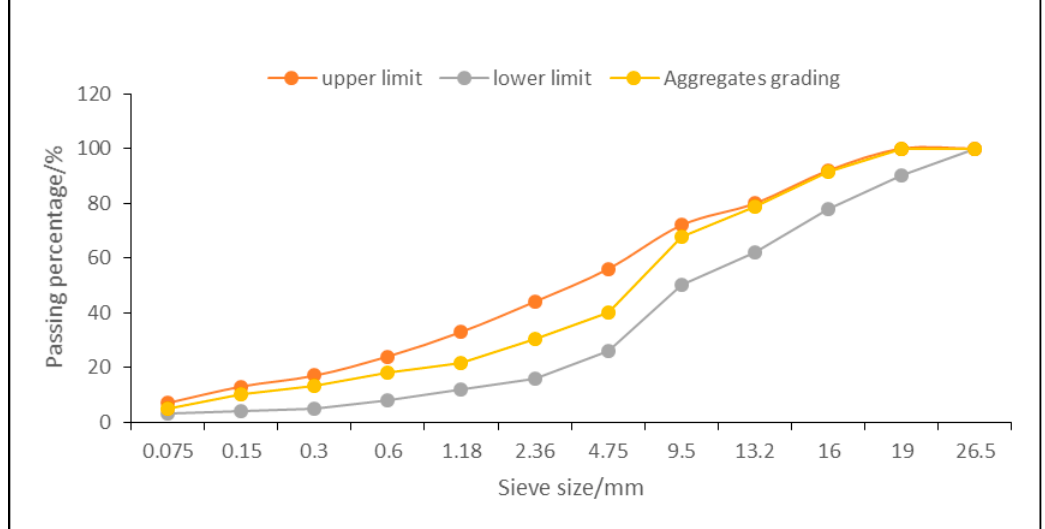
Figure 2. Gradation of the aggregates used in this study.